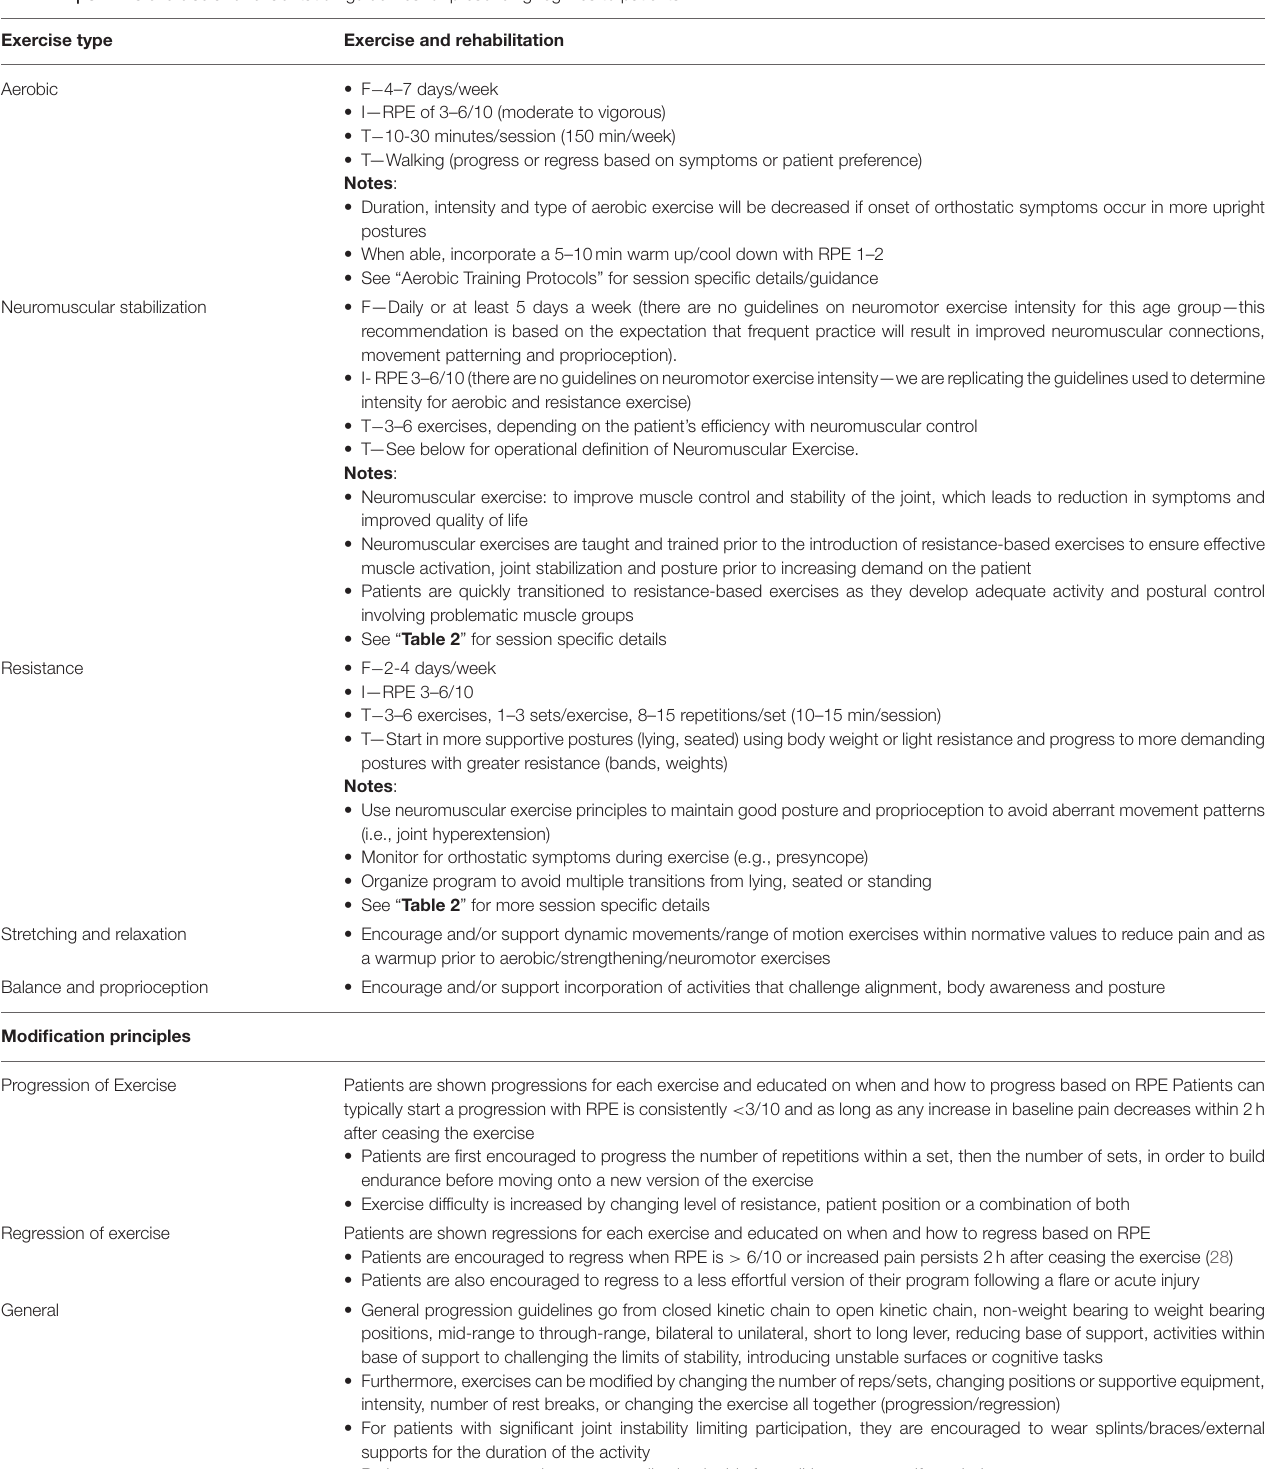
TABLE 1 | GEAR’s exercise and rehabilitation guidelines for prescribing regimes to patients. Exercise